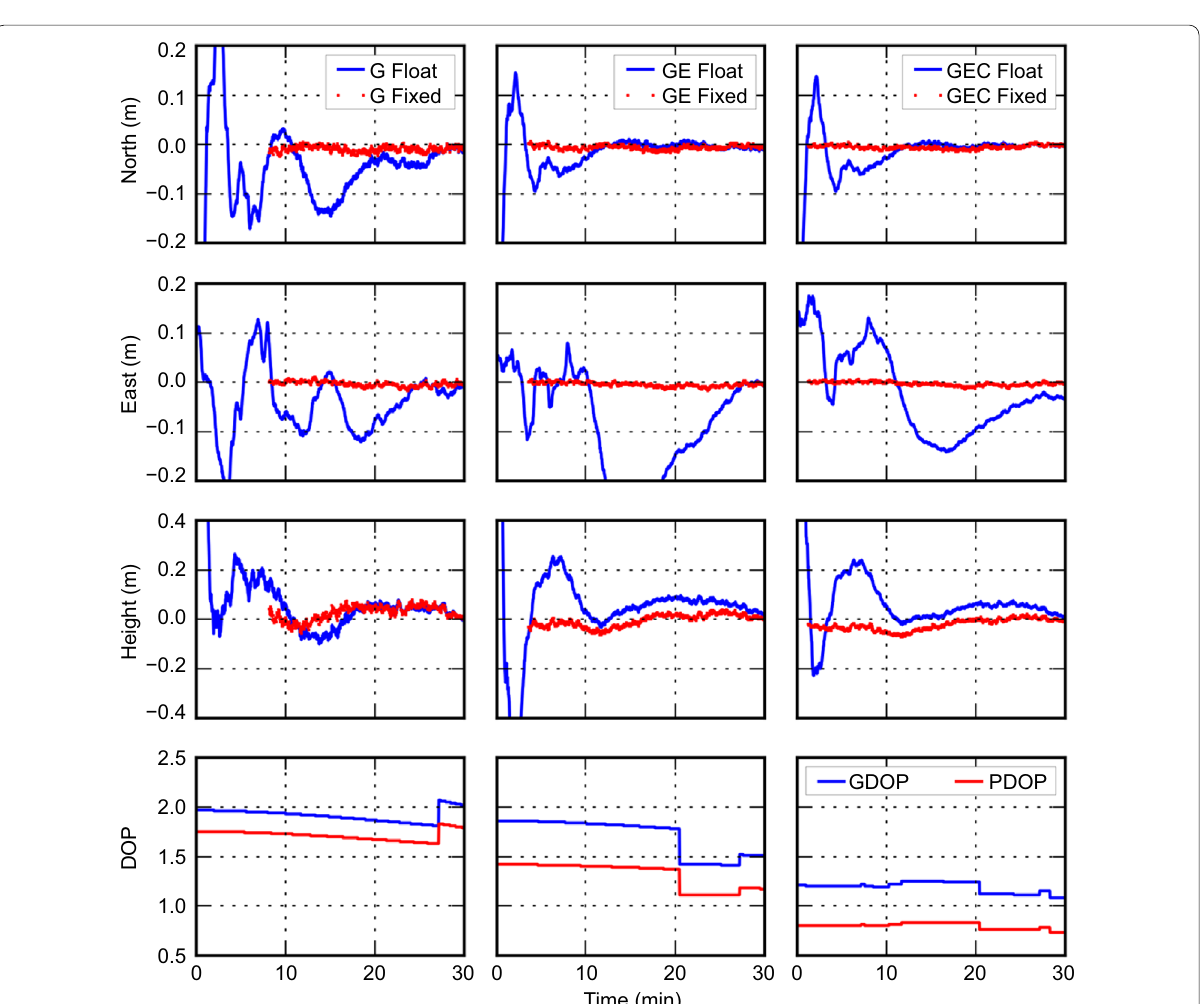
Fig. 10 30 min’s zooming in time series of PPP (blue line) and PPP-IAR (red dot) solutions of North (top row), East (the second row) and Height (middle row) components using GPS only (left), GPS/Galileo (middle) and GPS/Galileo/BeiDou (right) measurements. The PDOP and GDOP series (bottom line) are displayed as